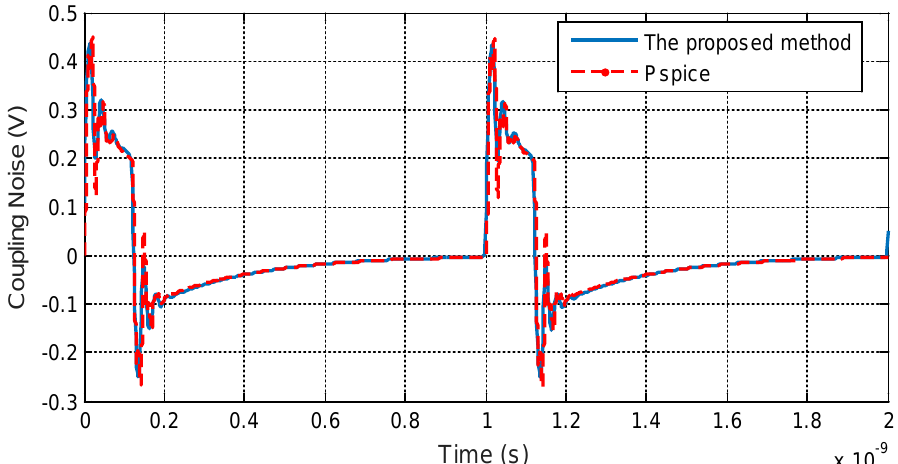
Figure 19. The proposed method and Pspice simulation of the TSV – TSV coupling noise with RDL ( l RDL = 500 µm and t r = 20 ps) at port 4.